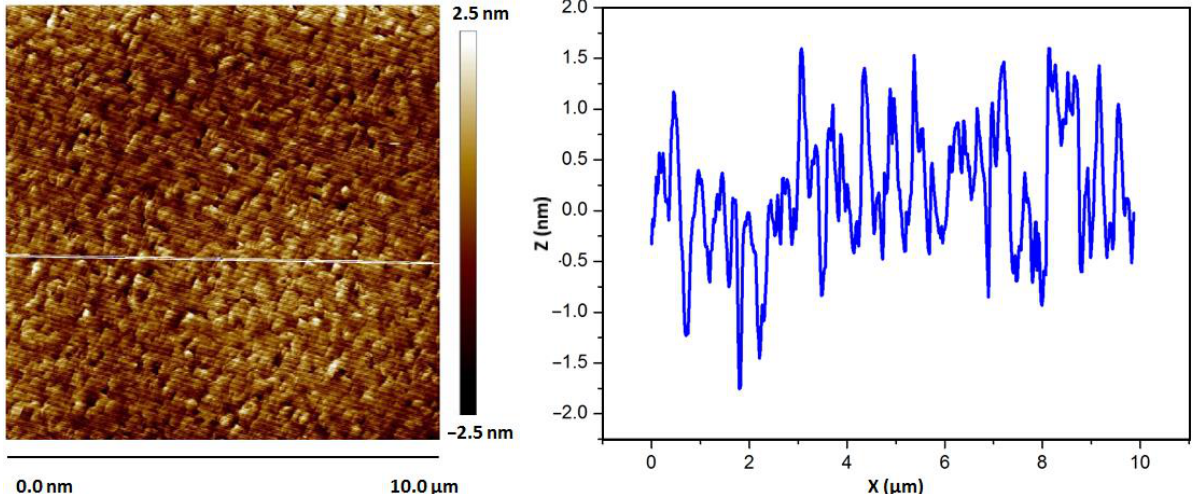
Figure 2. AFM scan image and cross-sectional data extracted along the white line for the estimation of the roughness of a silver layer.